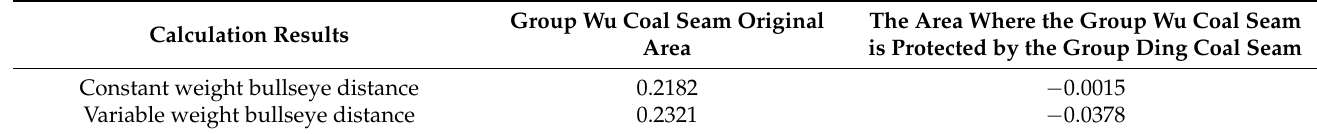
Table 8. Comparison of variable weight and constant weight projection bullseye distance for the group Wu protection effect.